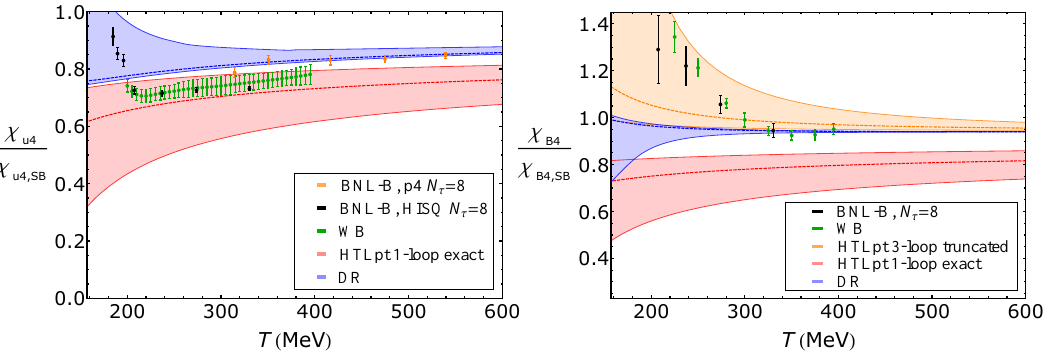
Figure 2. Fourth-order diagonal quark ( left ) and baryon ( right ) number susceptibilities, normalized to